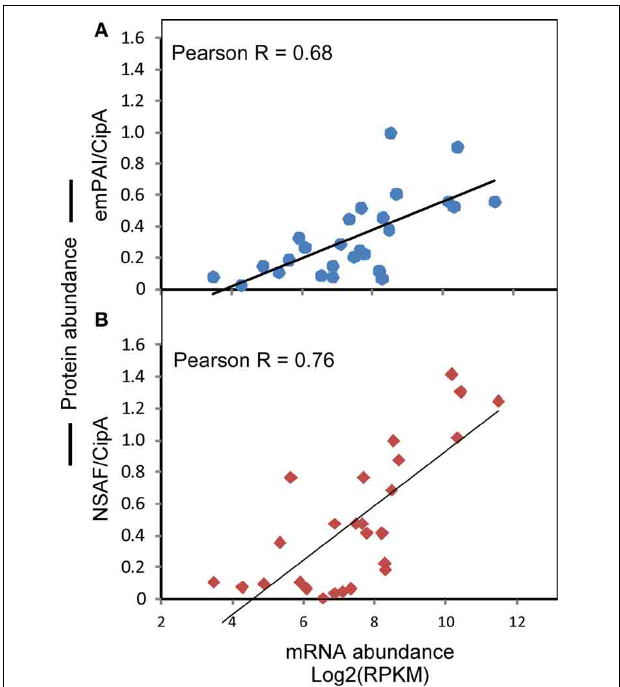
FIGURE 5 | Correlation between the observed gene abundances in this study and the published protein abundance data of cellulosomal components. (A) Correlation between Log2(RPKM) and emPAI/CipA. (B) Correlation between Log2(RPKM) and NSAF/CipA. The literature sources for data of emPAI/CipA and NSAF/CipA are described in the Results and Discussion